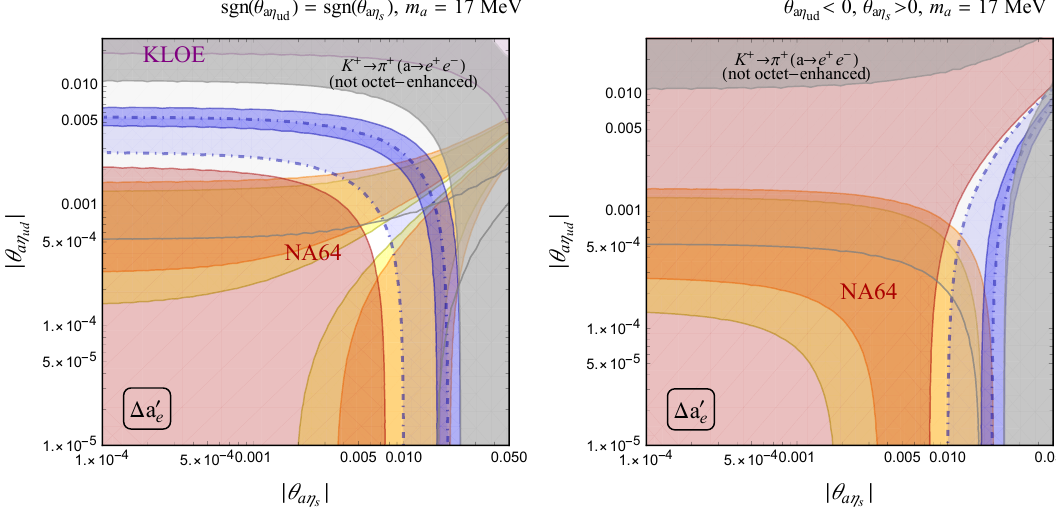
Figure 3 . Mutual parameter space for the ( g − 2) e and Atomki anomalies. Left: the light and dark yellow bands indicate the parameter space for the 17 MeV axion which can accommodate the Atomki anomalies for 8 Be and 4 He, respectively, when sgn ( θ aη from NA64 and KLOE in red and purple respectively, as in figure 2, assuming the correlation of electron couplings consistent with ∆ a 0 decays in the non octet-enhanced regime. Gray lines indicate the region that would be excluded in the octet-enhanced regime. Right: same parameter space when θ aη panels, the light (dark) blue shaded contours show regions where g γγ 95% C.L. for Q e /Q d = 1 / 3 (1 / 2)